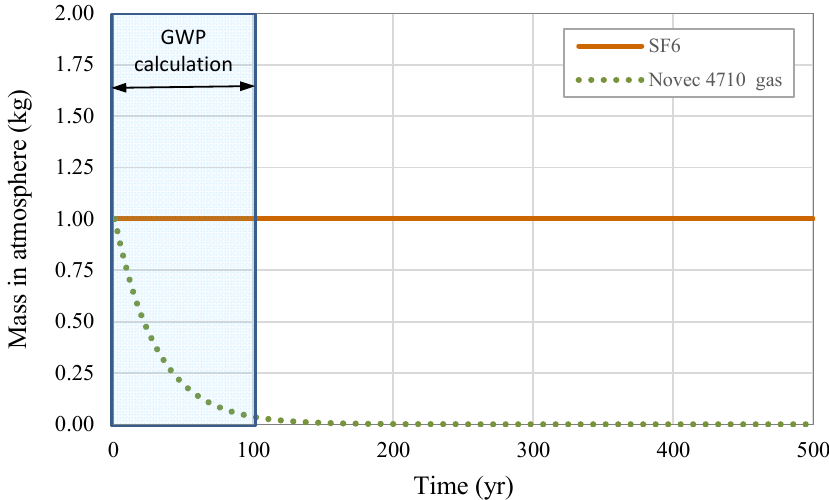
Figure 5. Residence time of insulating gas in the atmosphere, assuming 1 kg release of each com ‐ pound at time zero.